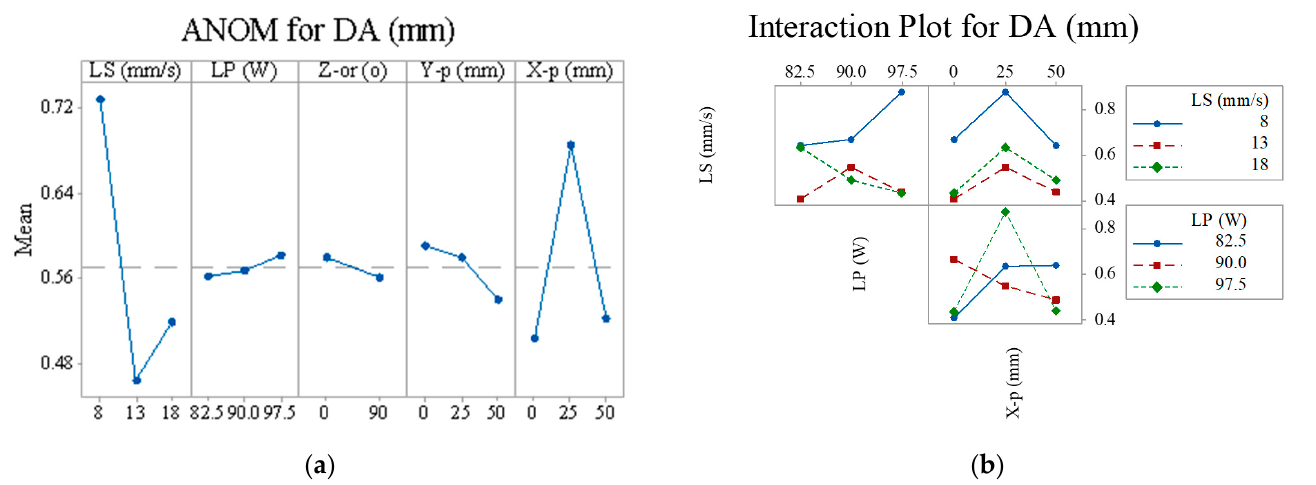
Figure 5. Process parameters plots: ( a ) ANOM plots for the DA and ( b ) interaction plots for the DA.